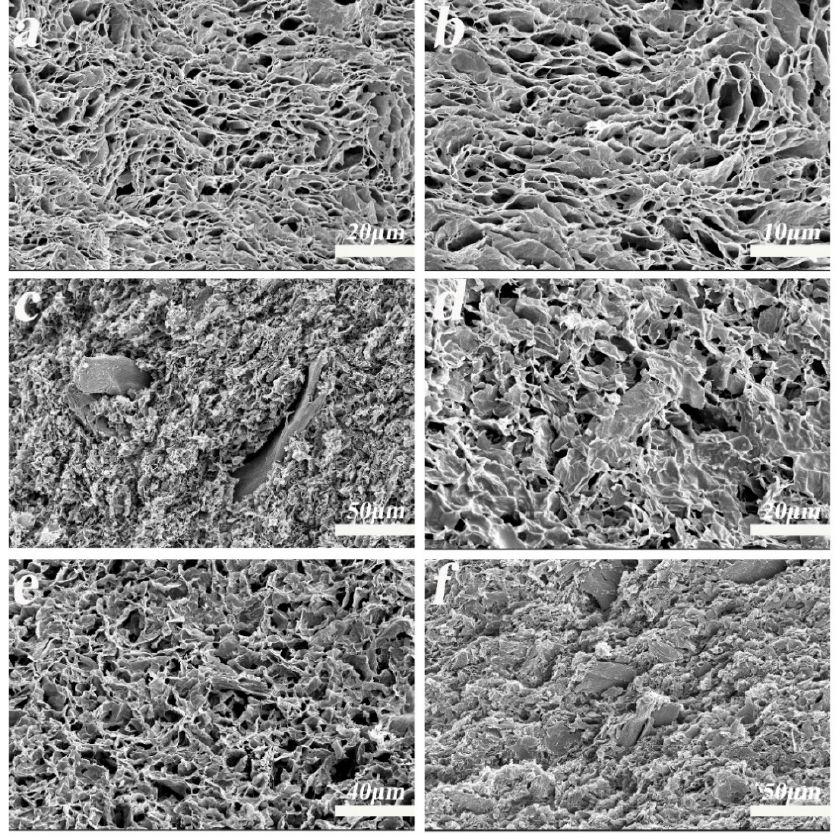
Figure 1. SEM images of GA-MCC-PEI aerogels: ( a , b ) GA-MCC-PEI-1, ( c , d ) GA-MCC-PEI-3, and ( e , f ) GA-MCC-PEI-5.